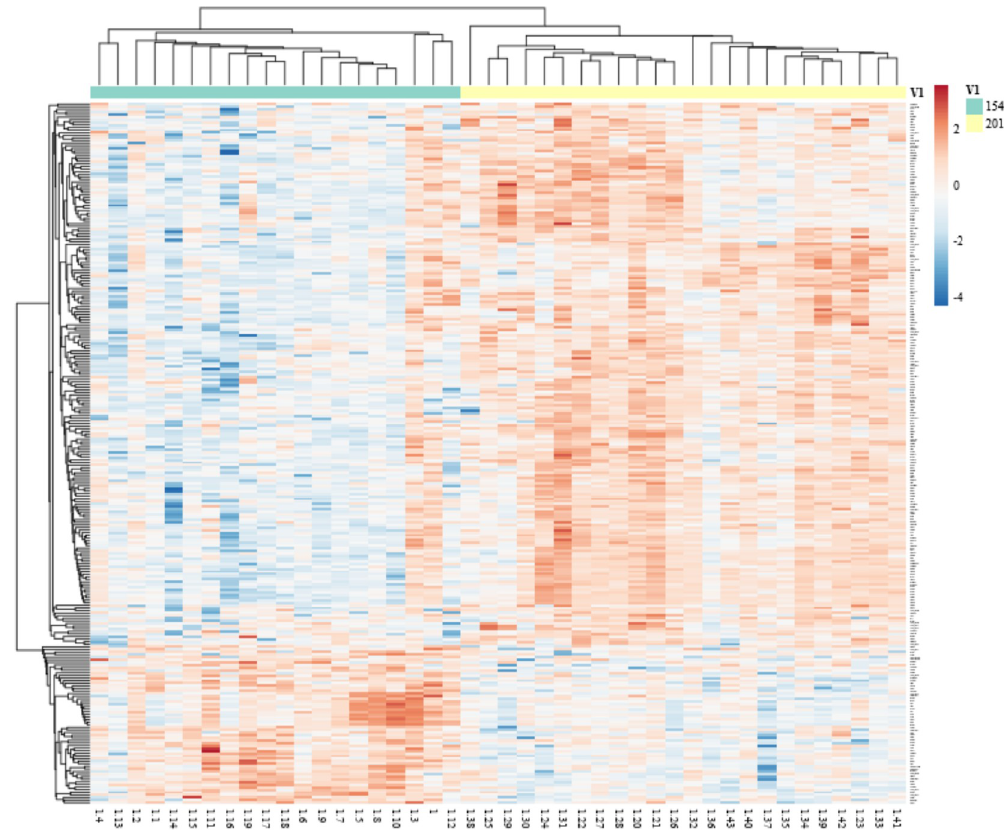
Fig 4. Heatmap of differently expressed genes with a fold change restriction [FDR � 0.05 and a log 2 fold change (log 2 FC) � |1|] in the longissimus muscle of calves on d 154 and d 201. Each row represents a differentially expressed gene, and each column is an individual calf. Columns under the green bar represent samples collected on d 154 and columns under the yellow bar represent samples collected on d 201. Red indicates upregulated genes and blue represents downregulated genes. Rows and columns are clustered using correlation distance and average linkage.